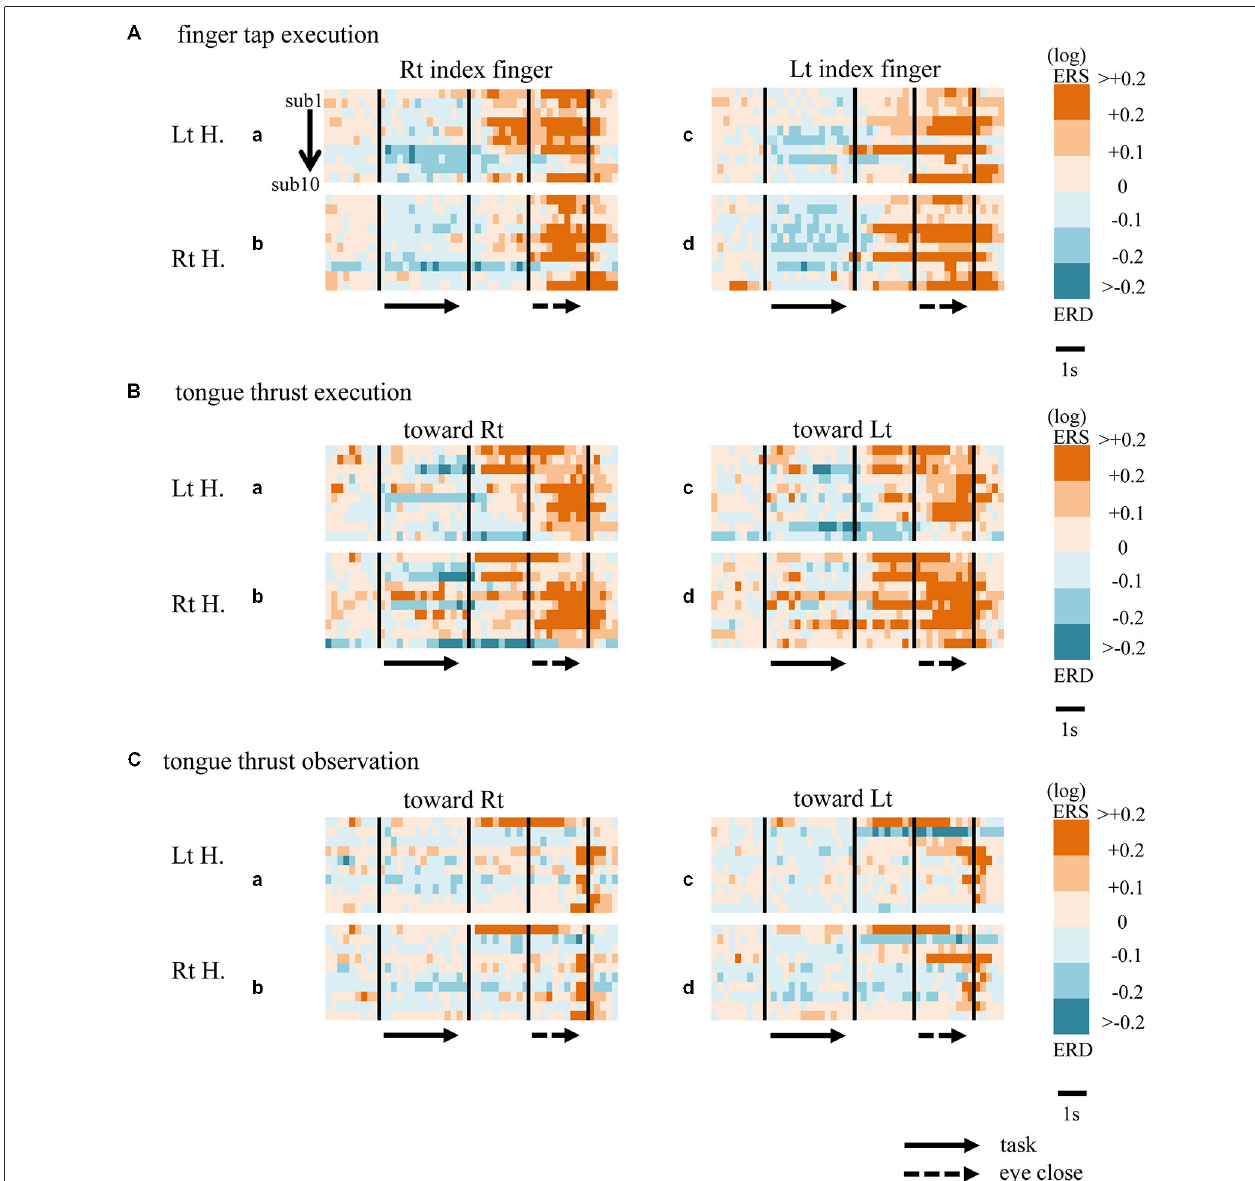
FIGURE 3 | Matrix chart of beta band ERD/ERS with time (horizontal scale) from all ten participants (sub1 − sub10, arranged vertically) . Light and deep blue indicates ERD, orange and red ERS. Matrices are for finger tap execution (A) , tongue thrust execution (B) , and tongue thrust observation (C) . H, hemisphere; Lt, left; Rt,